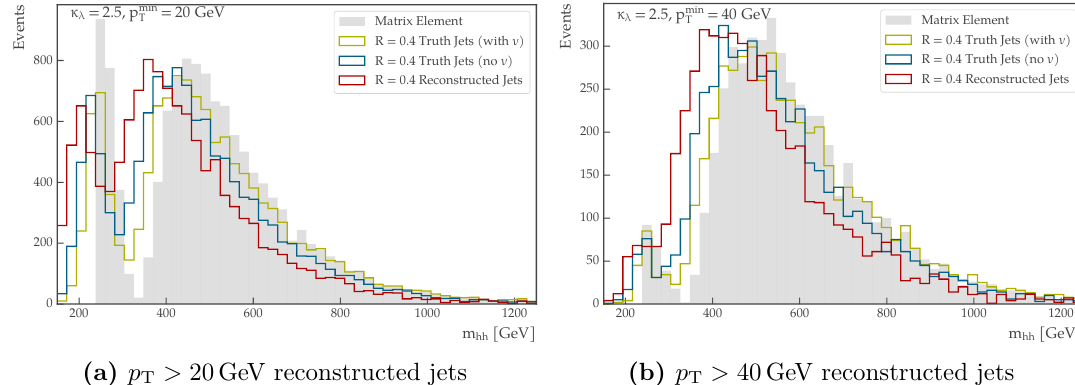
Figure 4. Distributions of the di-Higgs invariant mass m hh for κ λ = 2 . 5 where destructive in- terference is near-maximal. These are shown at different levels of reconstruction: the parton level predictions (grey shaded), truth jets including neutrinos (yellow line), truth jets without including neutrinos (blue line), and reconstructed jets after the detector emulation described in subsection 2.3 (red line). Small R = 0 . 4 radius jets are used that satisfy | η | < 2 . 5 . The p T thresholds in the